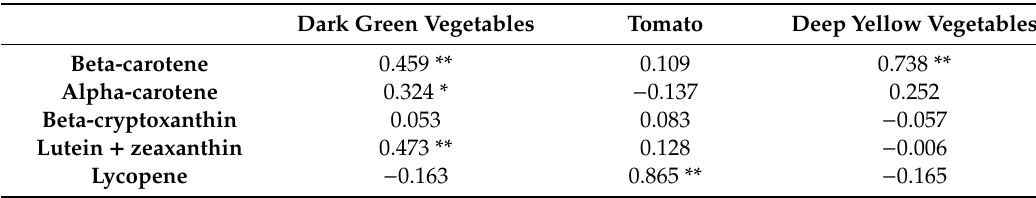
(Table 2) (i.e., lycopene and tomatoes r = 0.87; p < 0.01). Table 2. Associations between individual carotenoids and the carotenoid-rich vegetable subgroup (Pearson